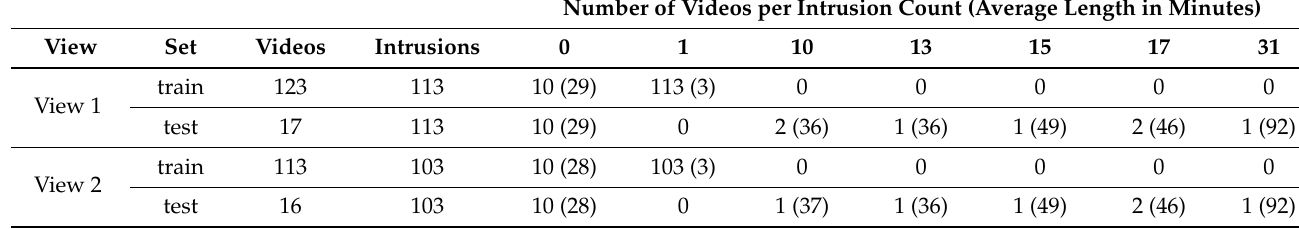
Table 1. i-LIDS sterile zone dataset